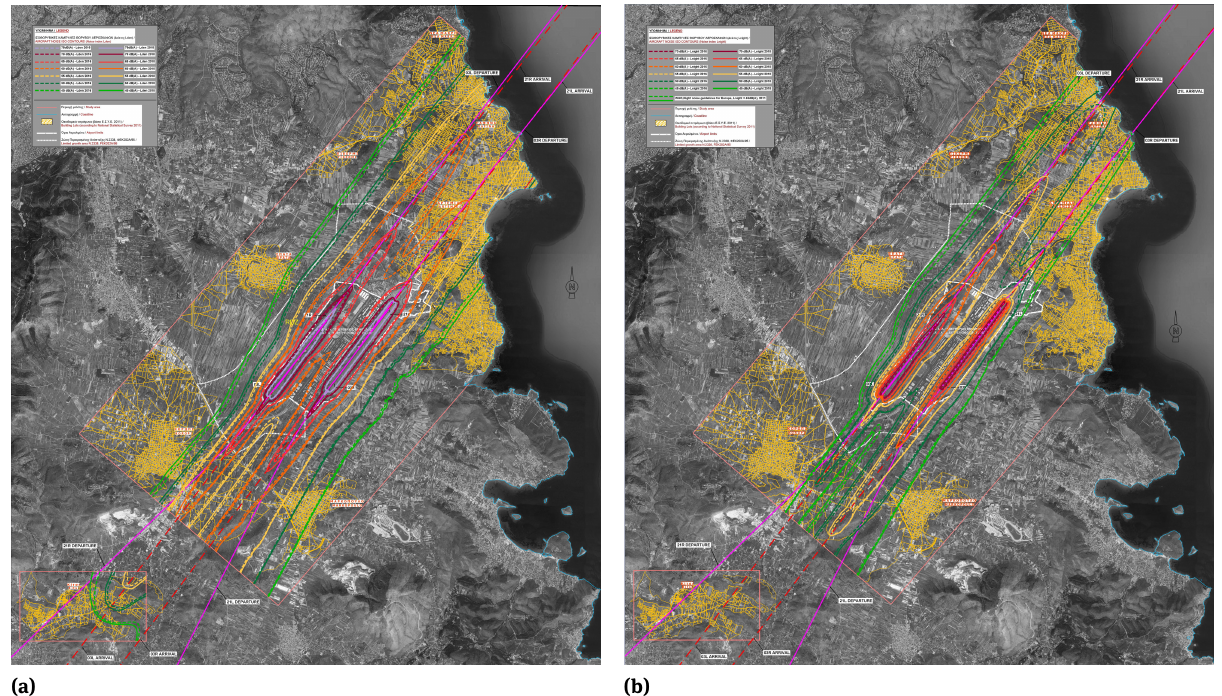
Figure 5: Comparison of SNM 2017 and 2019 (both based on ECAC.CEACDoc.29) for indexes L den & L night quirements. The impact of this procedure has significantly contributed to the further A/C noise reduction of the wider region of Artemis by avoiding right turns in low altitude as pervious